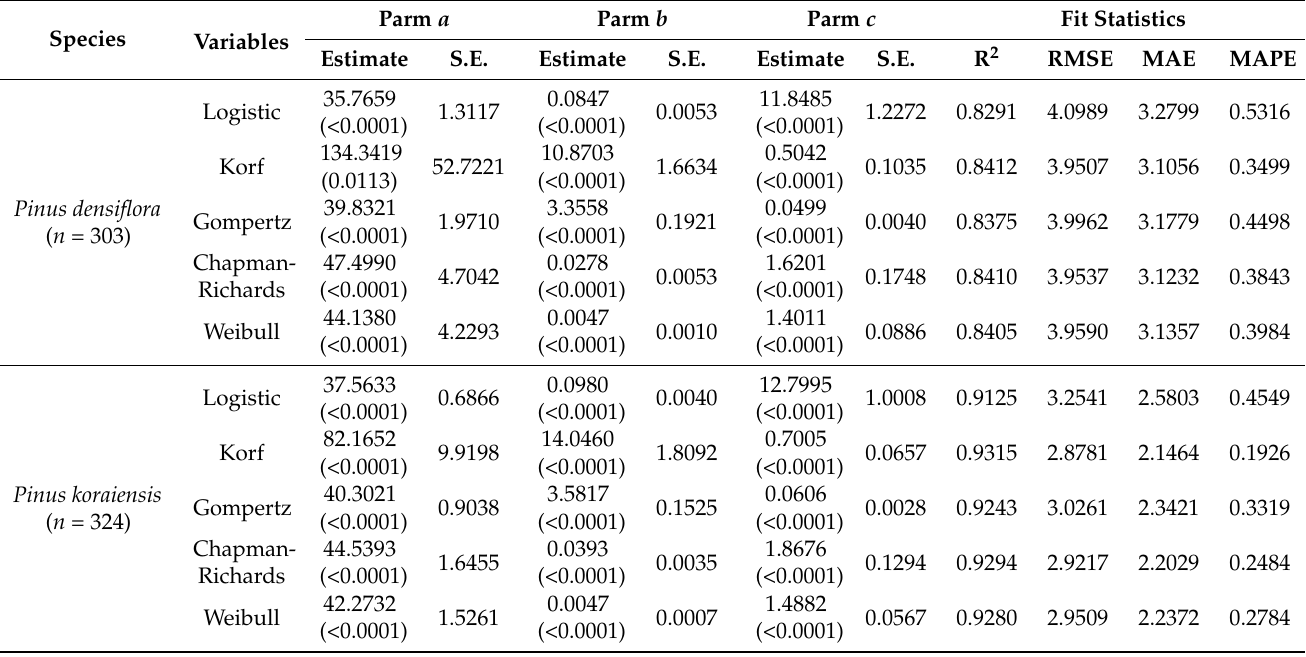
Table 3. Model parameters of DBH growth functions and indicators of